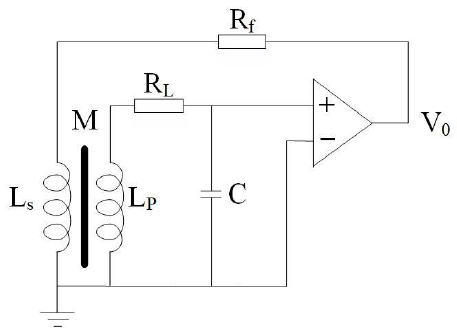
Figure 4. Schematic diagram of negative feedback technology.